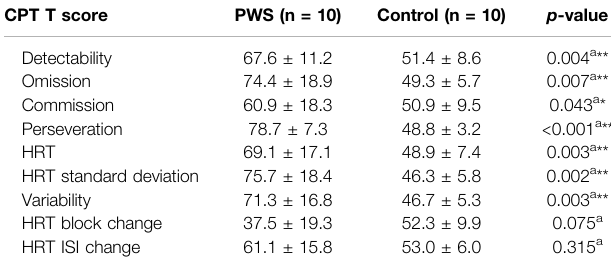
TABLE 1 | Demographic data of patients with Prader – Willi syndrome and control subjects.